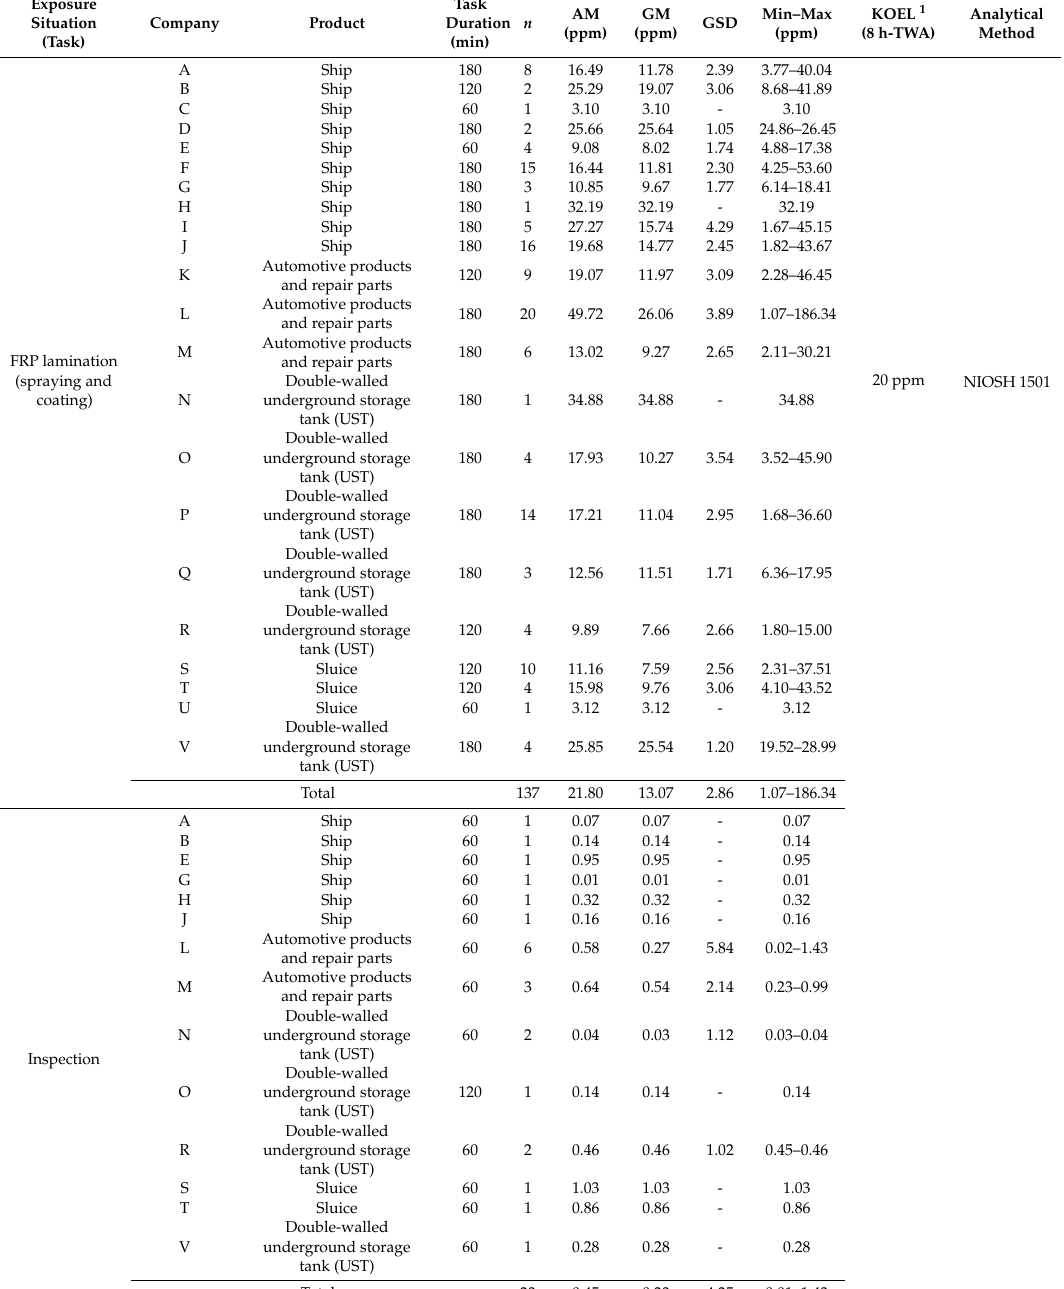
Table 4. Descriptive statistics of historical exposure measurements for styrene ( n = 160) during the FRP lamination (spraying and coating) and inspection situations by